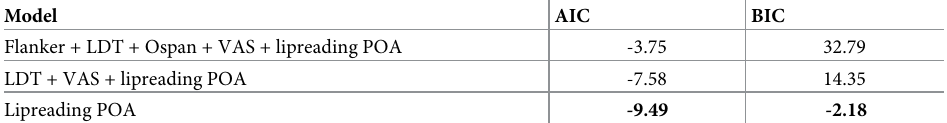
Table 3. Akaike Information Criterion (AIC) and Bayesian information criterion (BIC) for each of the mixed effects models compared. AIC and BIC values shown here are relative to the intercept-only model. Therefore, nega- tive numbers indicate that a model is better fit for the data than the intercept-only